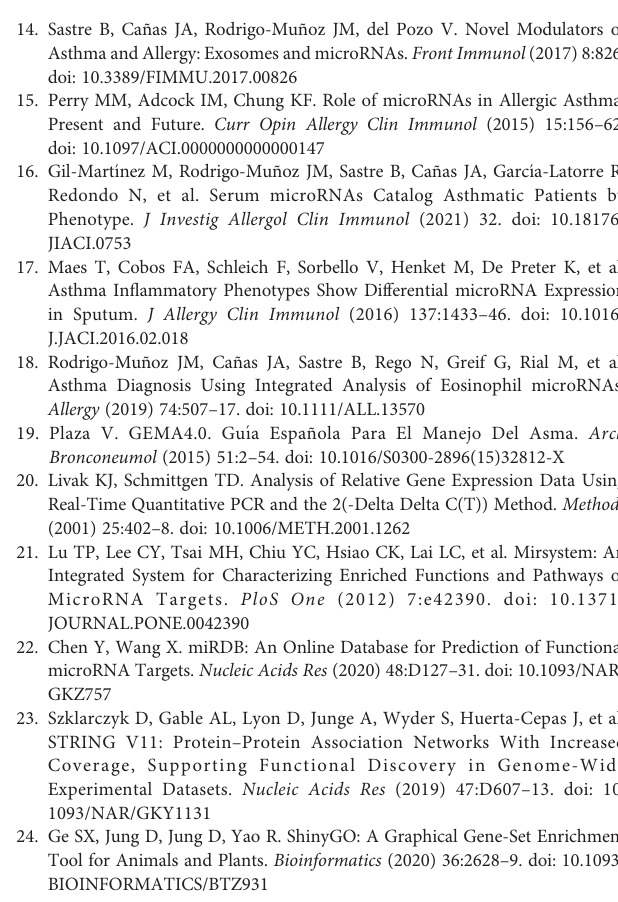
Supplementary Figure 1 | In silico gene enrichmentanalysisand representation of the pathways regulated by miR-144-3p (FDR<0.05), with a possible role in asthma pathophysiology. Lines imply connection and networking, thicker edges represent more overlapping genes, more intense blue nodes are more signi fi cantly enriched gene sets and bigger nodes are larger gene sets. FDR, False discovery rate. Supplementary Figure 2 | MiR-144-3p upregulation with arti fi cial miRNA MIMICs in bronchial smooth muscle cells reduces GATA3 expression (2 - DD Ct ). **p<0.01. BSMC, bronchial smooth muscle